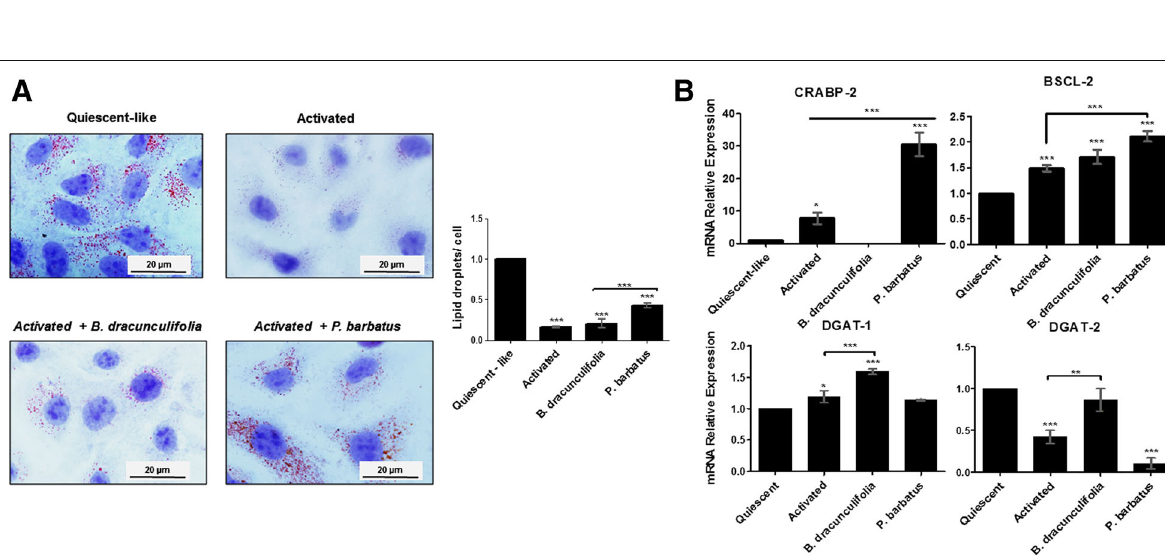
Fig. 3 Lipid droplets assemble in LX-2 treated with the medicinal plant extracts of Baccharis dracunculifolia and Plectranthus barbatus . ( a ) Lipid droplets (LD) distribution in different groups of LX-2 ( b ) Transcriptional level of molecules relevant to the assemble of LD in different groups of LX-2 cells by qRT-PCR. The graphs represent the mean values of at least three independent experiments ( p <